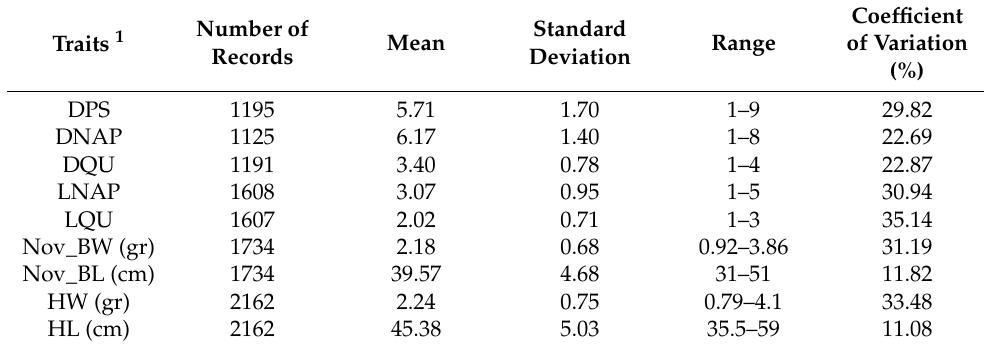
Table 2. Descriptive statistics for dried pelt, live grading and body weight and length traits in